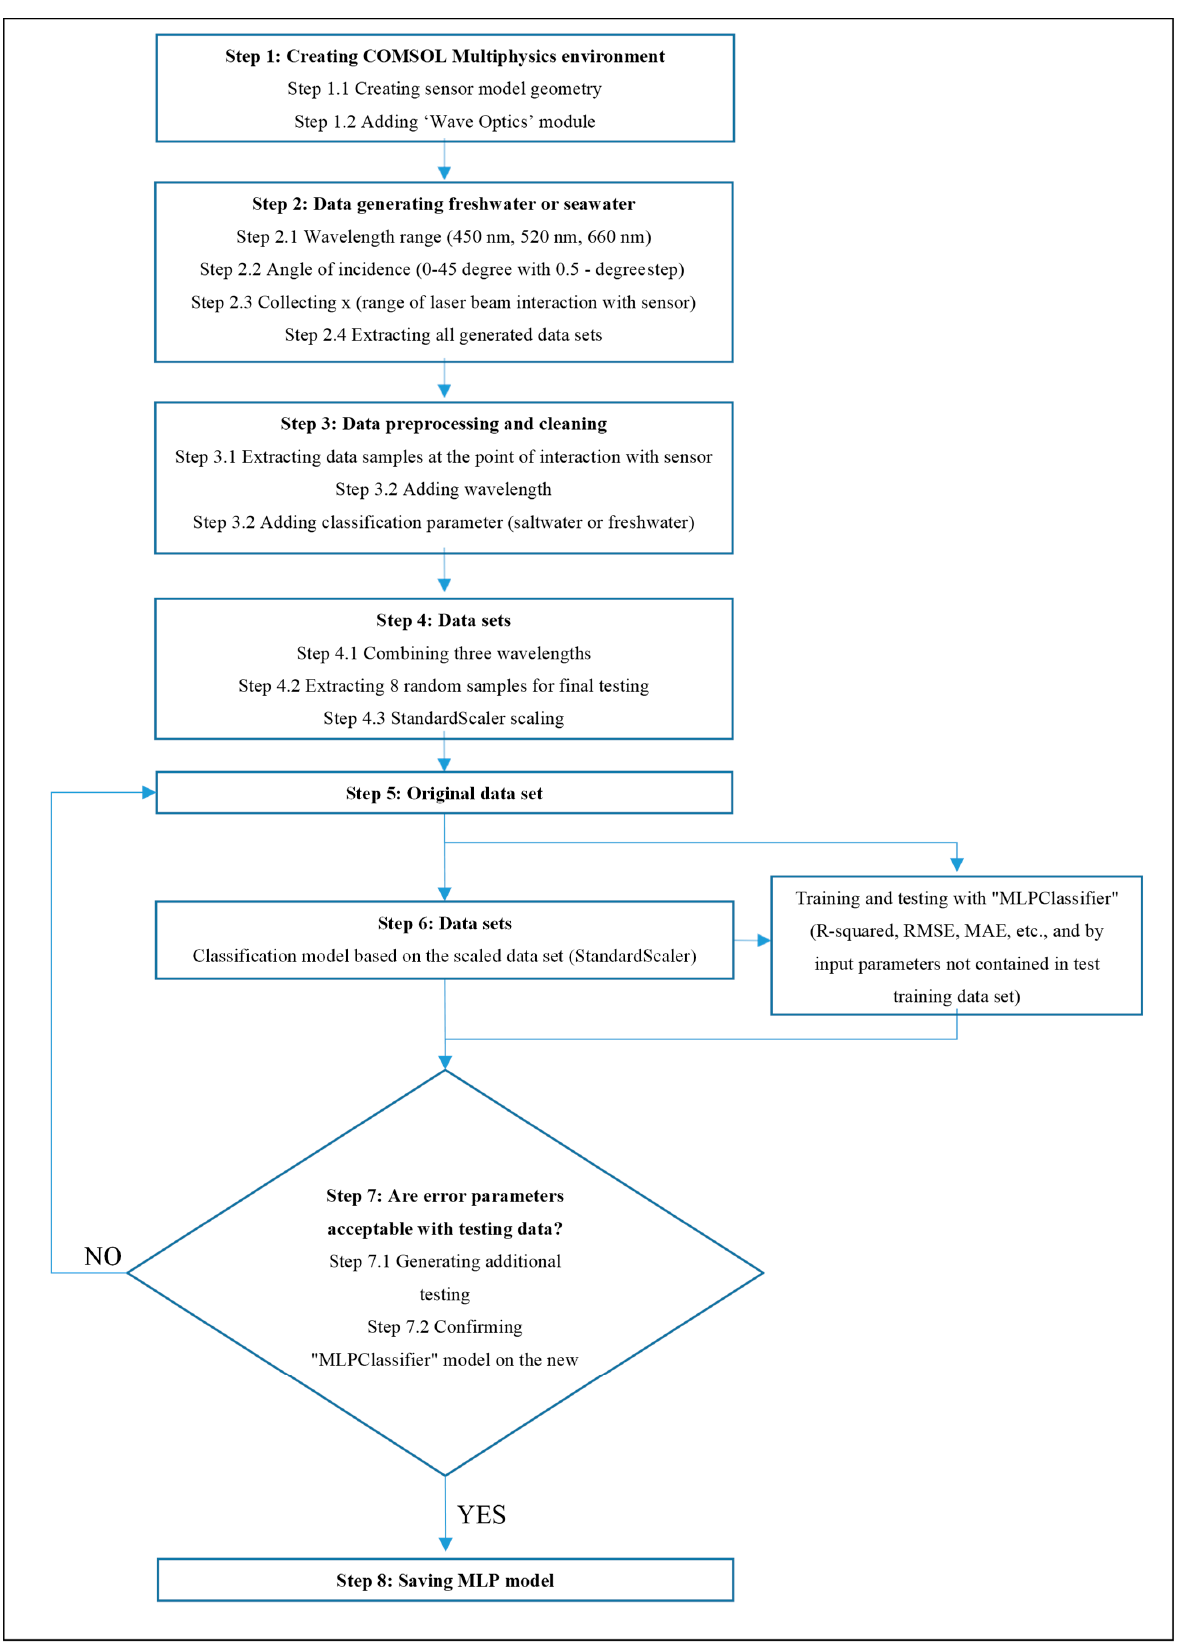
Figure 4. Water classification sensor